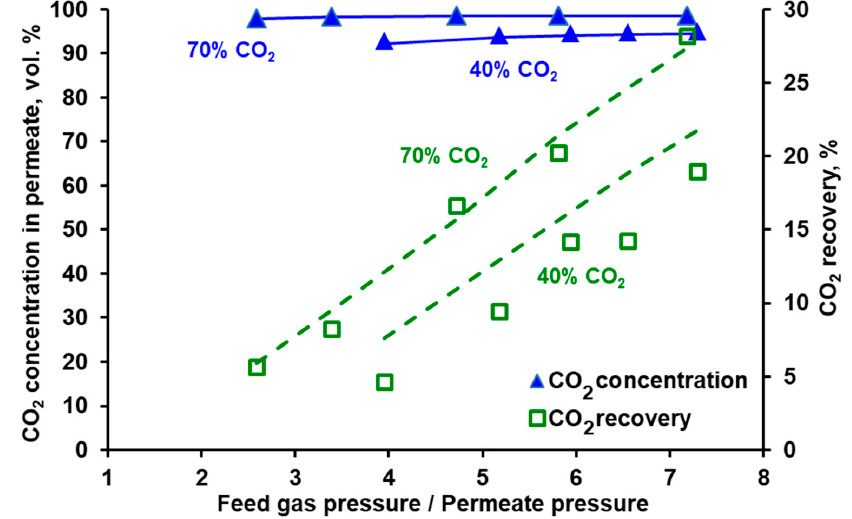
Figure 6. Experimental (points) and theoretical (lines) CO 2 purity and recovery in UBE UMS-A5 module against feed to permeate pressure ratio for various carbon dioxide content in the feed CO 2 /N 2 mixture. Feed gas flow rate: 0.05 kmol h − 1 , temperature: 295 K. Standard deviation; purity = ± 0.4, recovery = ± 0.1.